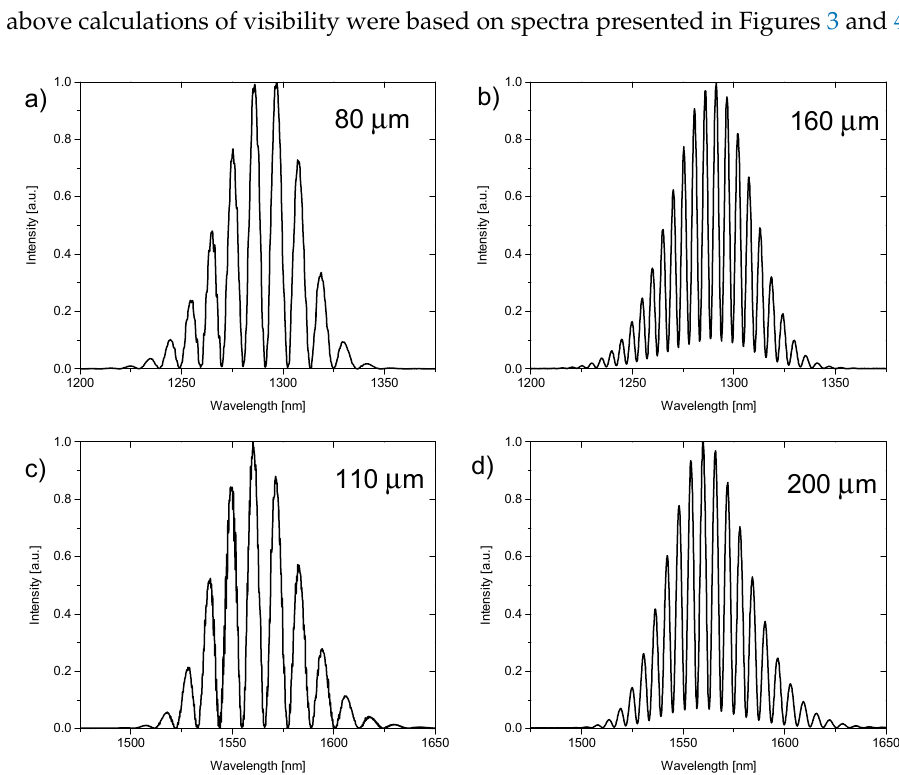
Figure 3. Spectra measured on BD-NCD-Si while the cavity was filled with air. Spectra obtained for 1290 nm and cavity lengths ( a ) 80 µm and ( b ) 160 µm. Spectra obtained for 1560 nm and cavity lengths ( c ) 110 µm and ( d ) 200 µm.